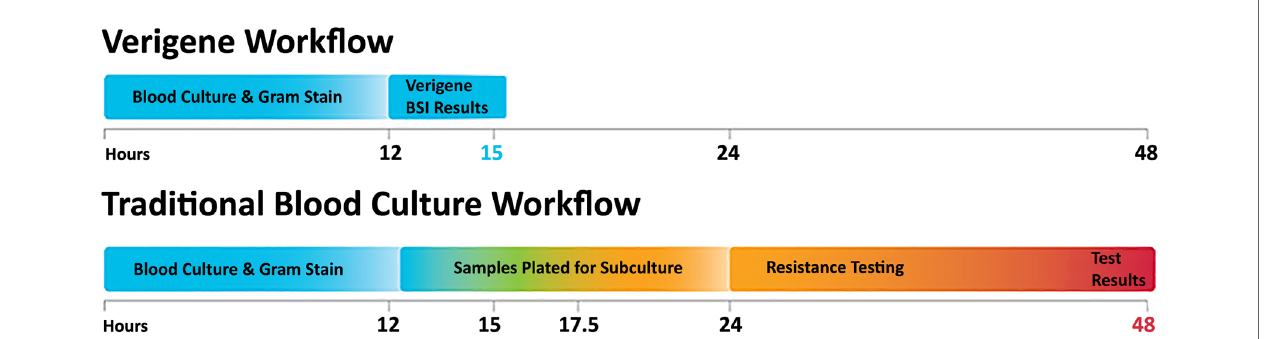
FIGURE 2 | The VERIGENE ® work fl ow as compared to traditional blood culture. Positive blood cultures are evaluated by Gram stain and the appropriate VERIGENE Blood Culture Nucleic Acid Test is selected. Set-up, running the test, and reporting can be easily completed within 3 hours. With traditional culture-based work fl ows, subculture can add an additional 12 hours, and resistance testing (when required) can add another day so that the fi nal results may not be available for 48